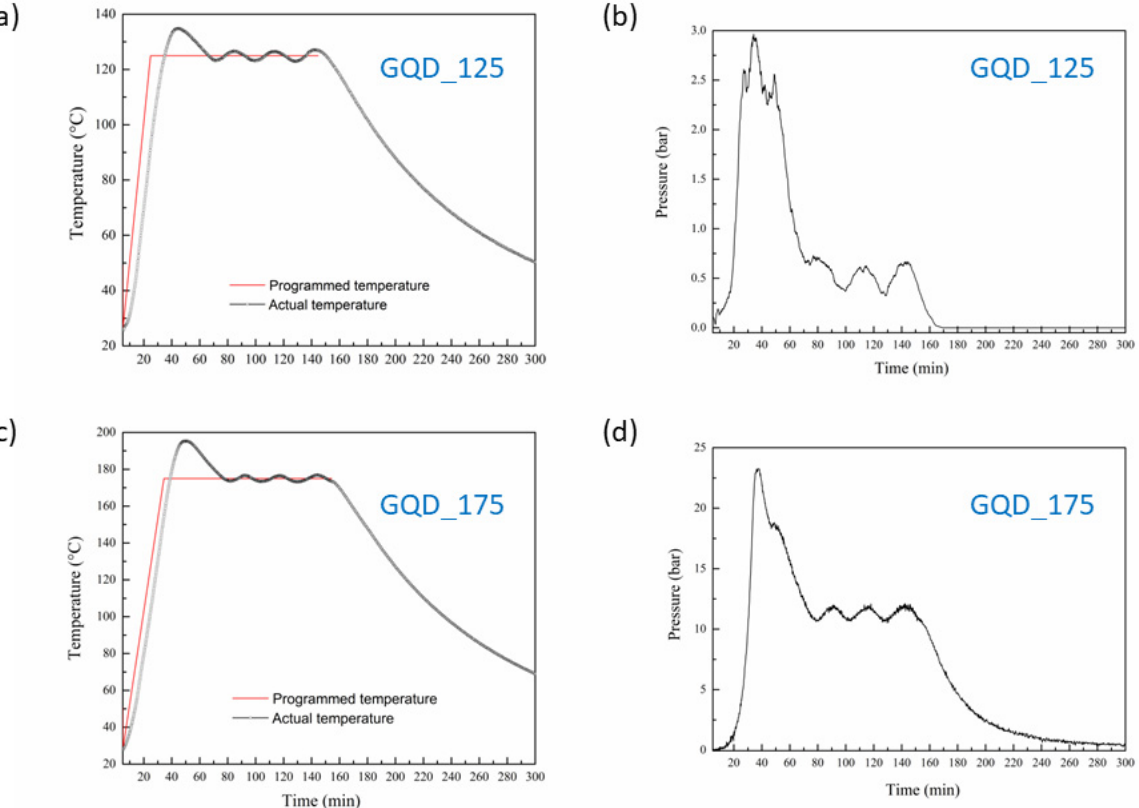
Figure 5. Evolution of temperature (parts ( a ) and ( c )) and pressure (parts ( b ) and ( d )) inside the hydrothermal reactor during the syntheses of the GQD_125 (parts ( a ) and ( b )) and GQD_175 (parts ( c ) and ( d )) samples.